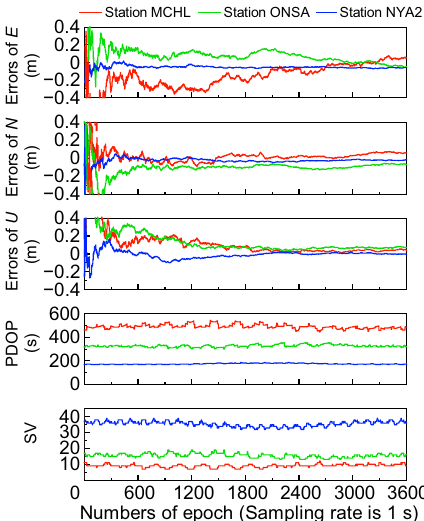
Fig. 10 RMSEs of static Doppler positioning with different noise levels at nine